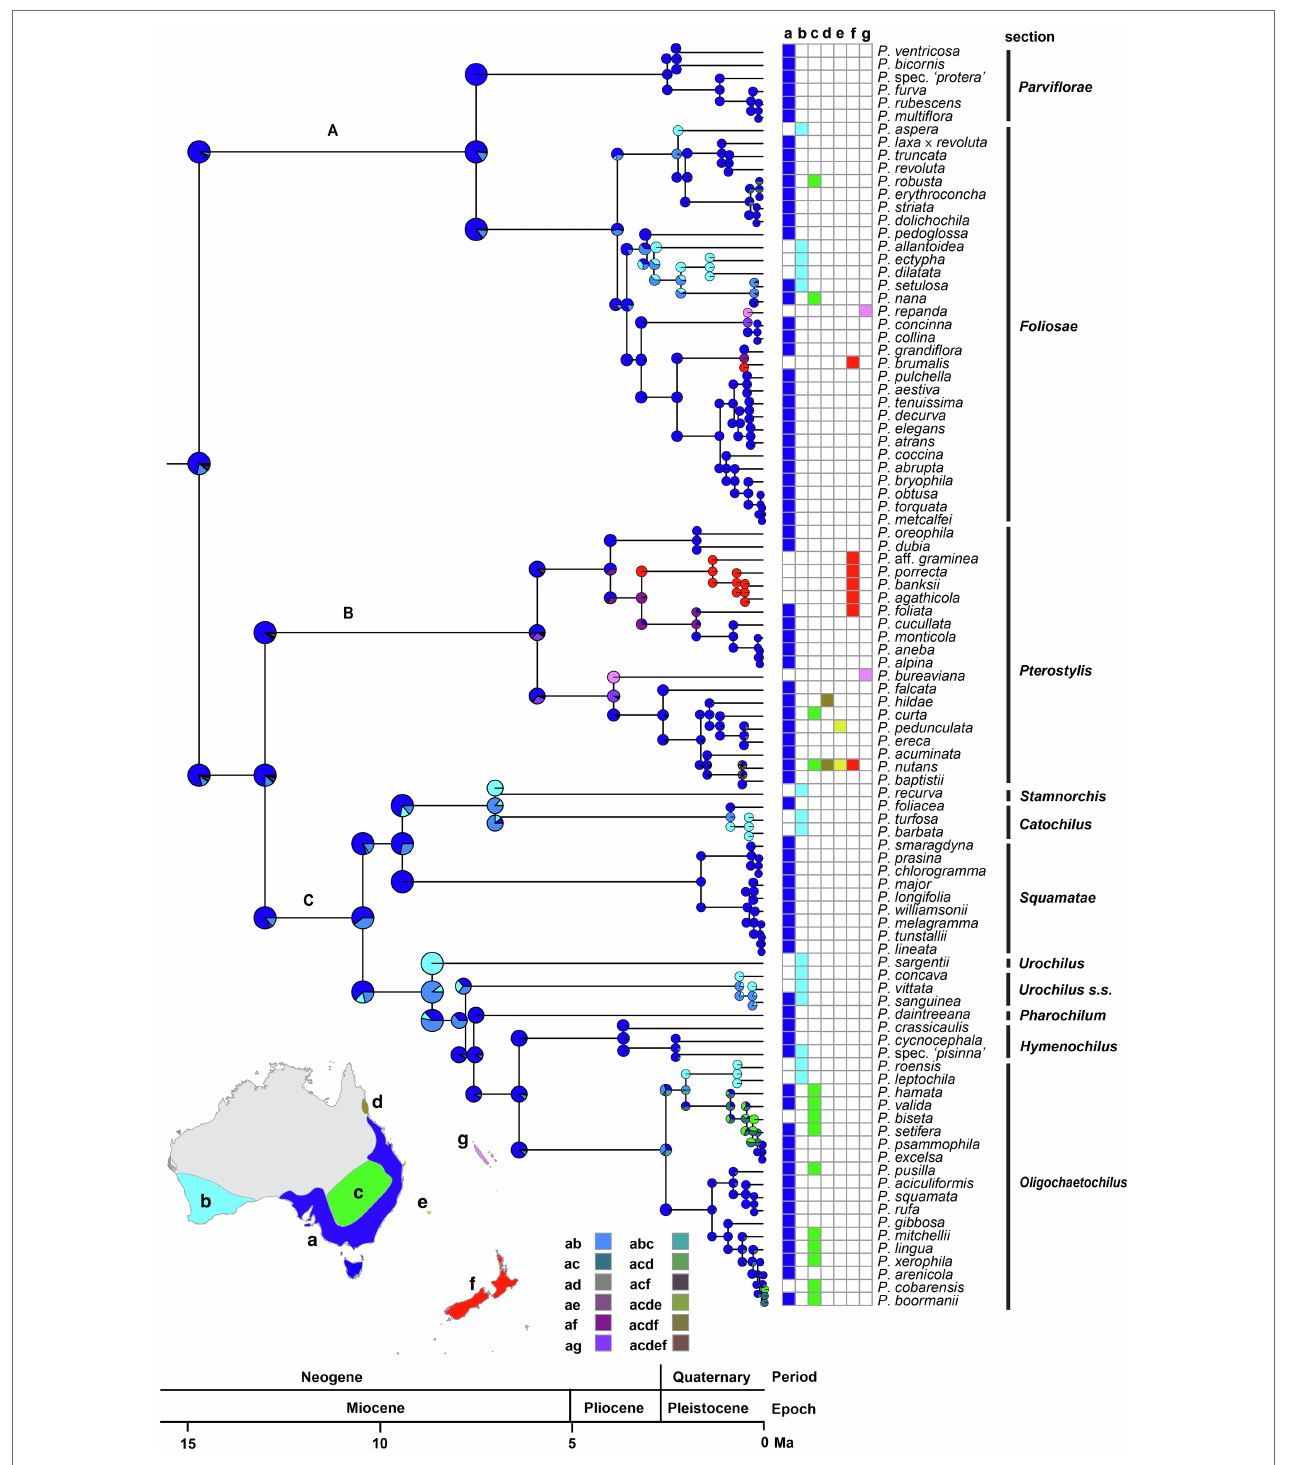
FIGURE 6 | Ancestral-range estimation in Pterostylidinae s.s. Maximum likelihood estimation was carried out under the dispersal-extinction cladogenesis (DEC) model and used the maximum-clade credibility tree from divergence dating analysis based on 25 plastid genes and an uncorrelated molecular clock model under the birth–death tree prior. Pie diagrams depict the relative probabilities of ancestral ranges. Relative probabilities of all alternative range evolutionary scenarios are provided in Supplementary Material S4.2 . Map insert shows area delineation and grid depicts area coding for each species. a: Euronotian region; b: southwest Australia; c: Eremaean region; d: Northern region (subregion Atherton), e: Lord Howe Island; f: New Zealand and g: New Caledonia. The three major clades in Pterostylis are labelled above branches (as A, B and